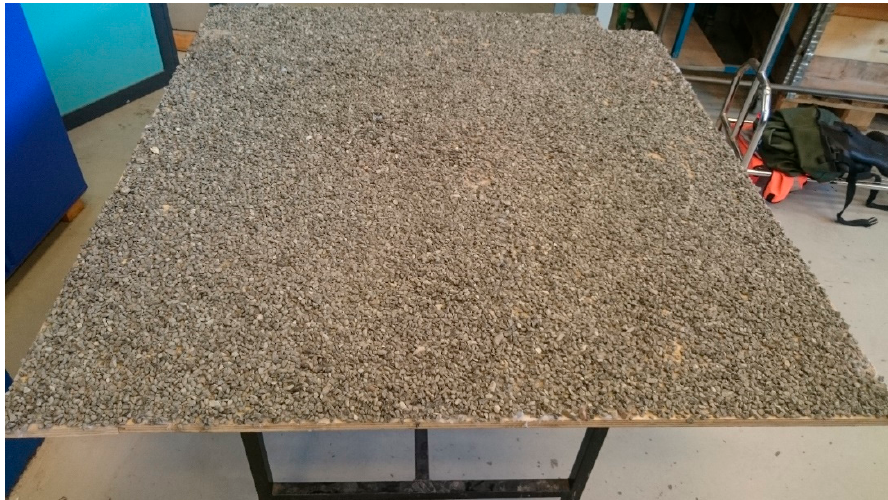
Figure 5. Plywood plate with glued Class V rocks. Used to increase the roughness of the impermeable interface.